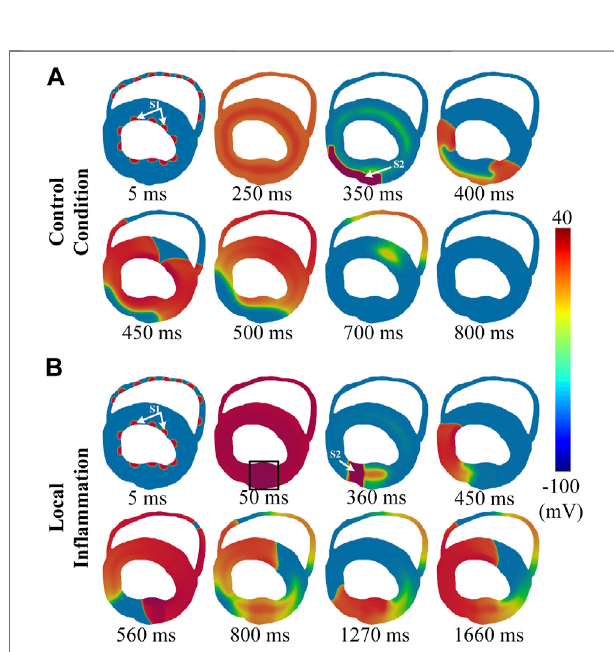
FIGURE 6 | Induced reentry arrhythmias in rat ventricular slices under conditions of (A) control and (B) local in fl ammation. The S1 and S2 stimuli are marked by white arrows, while the in fl ammatory region is indicated by a black